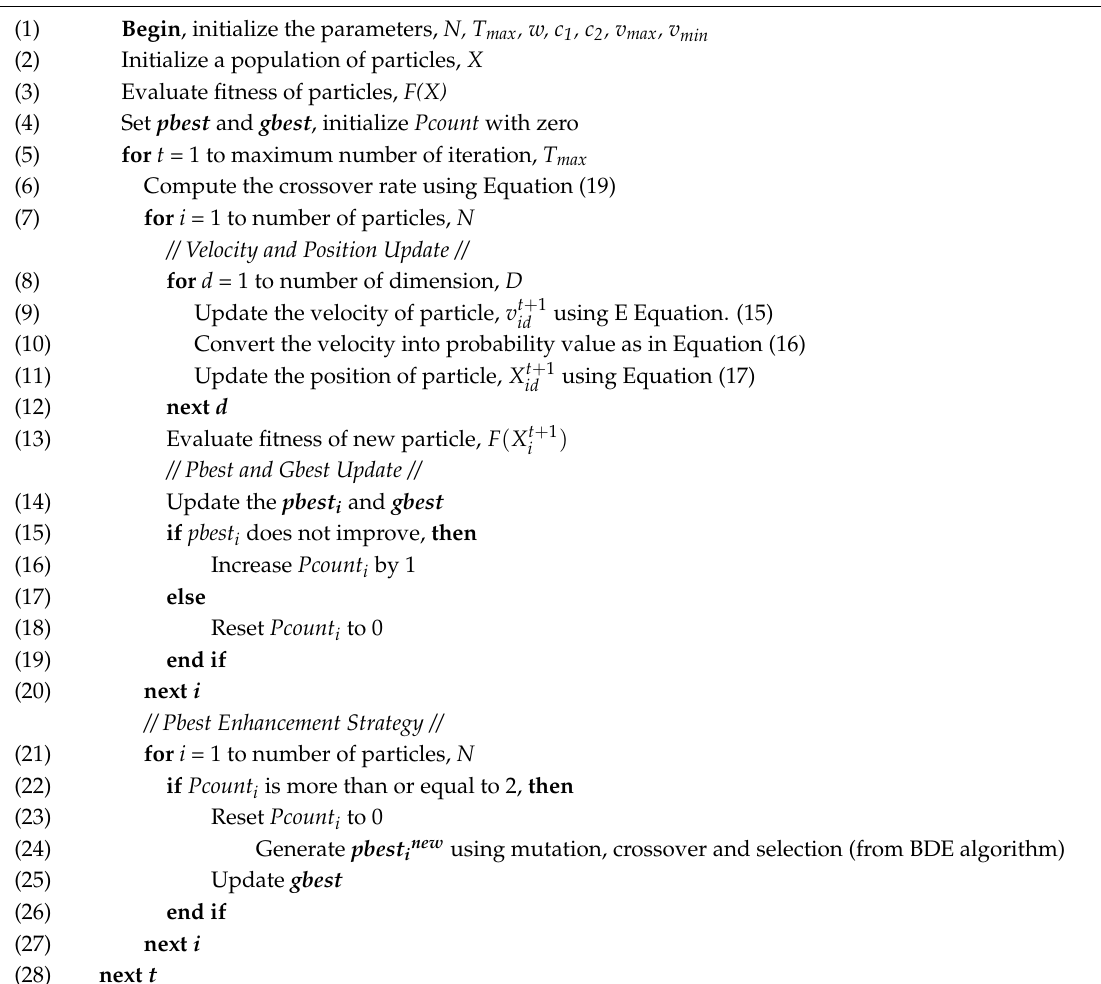
Algorithm 4. Pbest-Guide Binary Particle Swarm